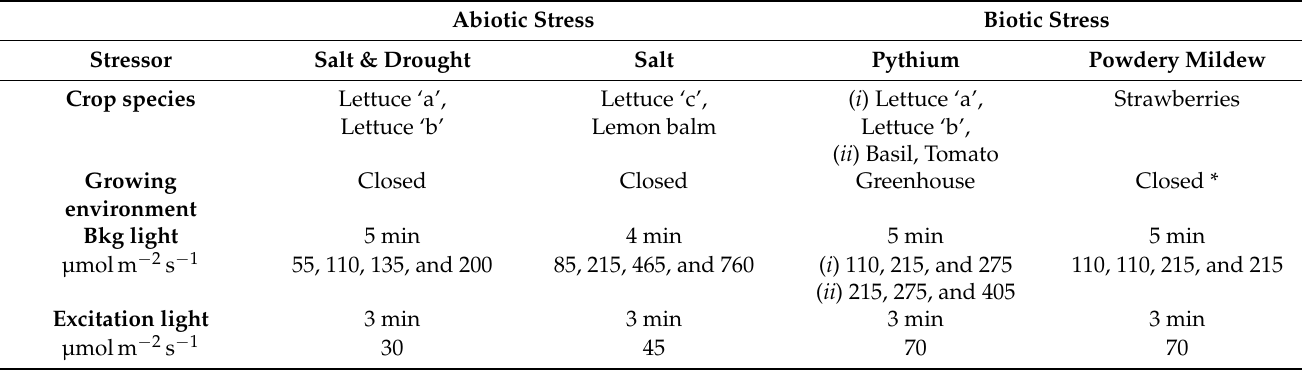
Figure 1. ( a ) Incident light (background and excitation) within PAR, repeated for four different background light levels. ( b ) Fluorescence signal (integrated over wavelengths 720–760 nm). Table 1. The settings for all experimental